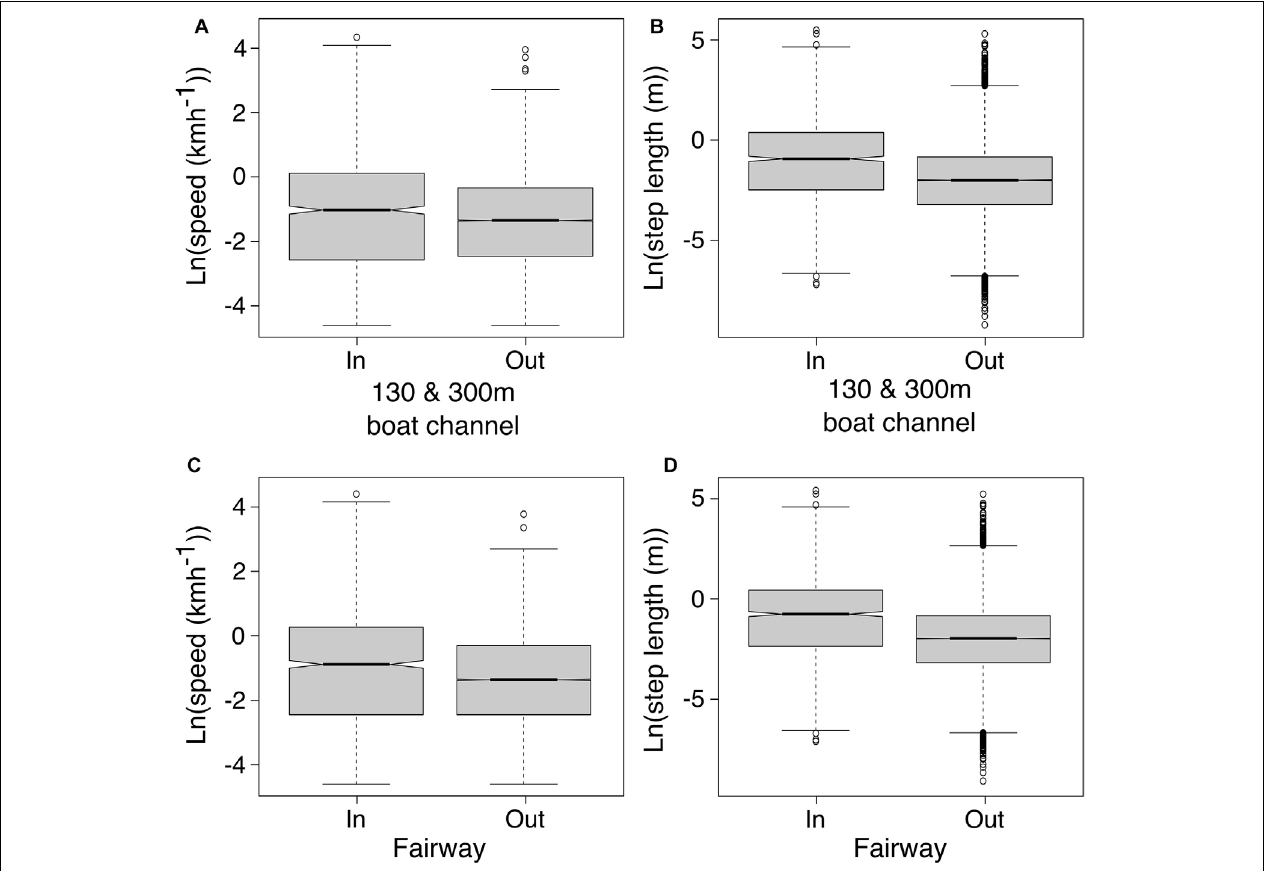
FIGURE 4 | Estimated averages of natural log transformed manatee swimming speeds in and out of 130 and 300 m channels (A) and shipping fairways (C) and natural log transformed step lengths in and out of 130 and 300 m channels (B) and shipping fairways (D) for tagged manatees.